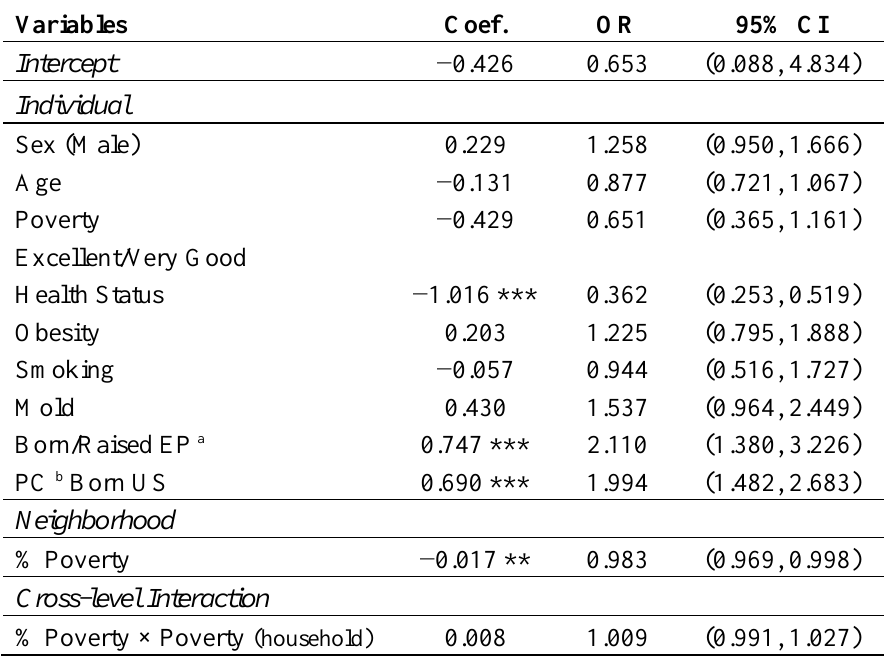
Table 4. Cross-level interaction, neighborhood percent poverty by individual poverty (Model